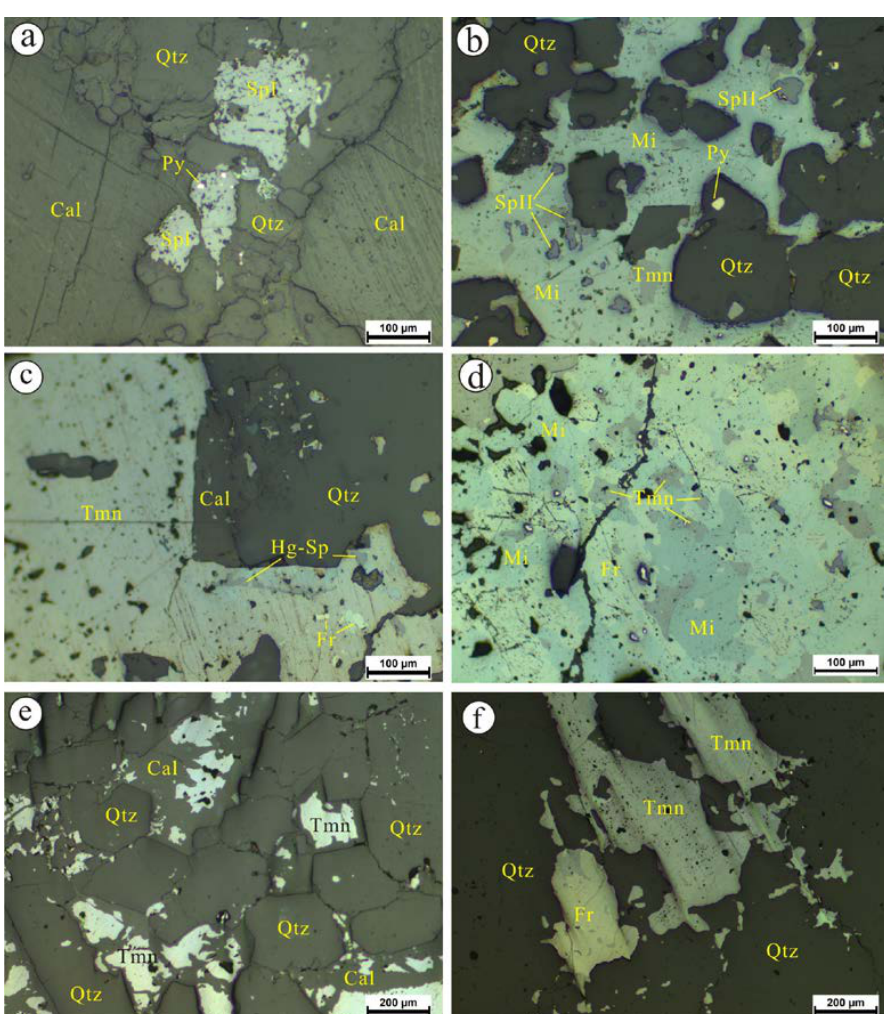
Figure 6. Photomicrographs of ore minerals and textures of the Dongping deposit: ( a ) sphalerite I (SpI) with pyrite (Py) hosted in quartz (Qtz); ( b ) sulfides corroding and filling the interstices in quartz, sphalerite II (SpII) forming island inclusions in miargyrite (Mi), with selenium metacinnabar also included by miargyrite; ( c ) sphalerite II as inclusions hosted in selenium metacinnabar; ( d ) complex sulfides aggregated with selenium metacinnabar replaced by Hg-bearing freibergite (Fr), and Hg-bearing freibergite replaced by miargyrite (Mi); ( e ) selenium metacinnabar preferentially replacing calcite (Cal) in quartz; and ( f ) irregular tiemannite and Hg-bearing freibergite in interstices in quartz.